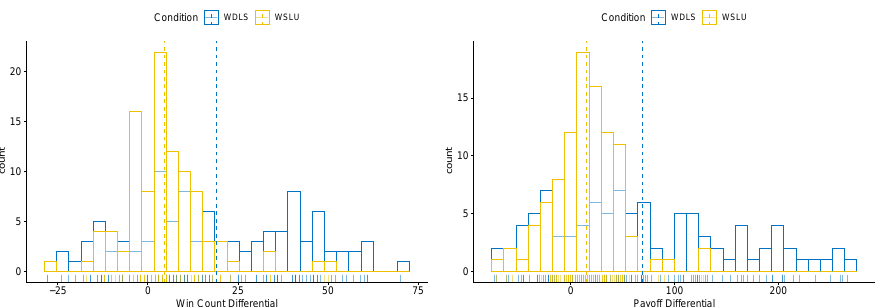
Figure 8. The empirical distribution of win count differentials ( left ) and payoff count differentials ( right ). The differentials are computed as performance difference between human players and computer algorithms. The dash lines indicate the average differentials within each group.